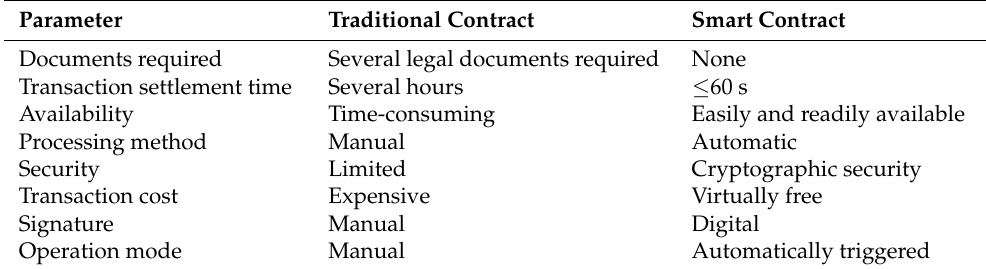
Table 1. Comparison of a traditional contract versus a smart contract .